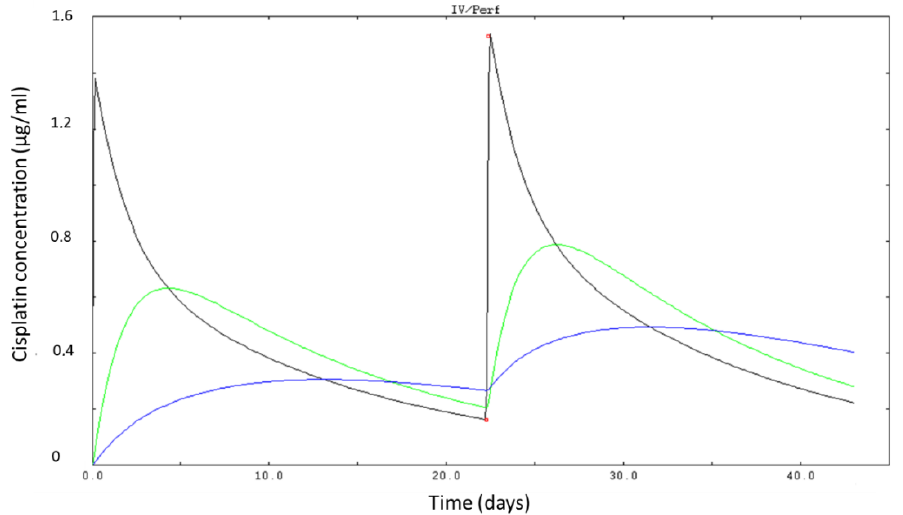
Figure 2. Time-concentration profile simulated after Bayesian identification of cisplatin pharmacokinetic parameters in a representative patient. Red dot: measured concentration in plasma. Black line: first compartment, green line: second compartment, blue line: third compartment (Kinetic Pro software caption).